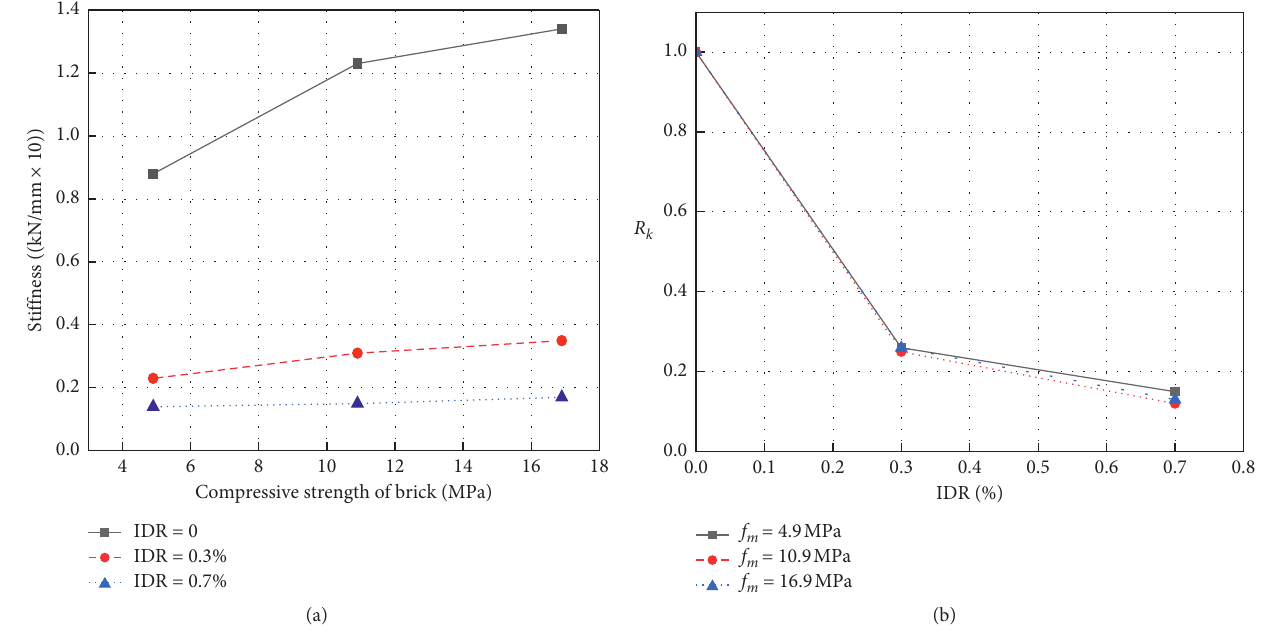
Figure 15: The effect (a) masonry strength and (b) IP damage on the OOP stiffness of the infill